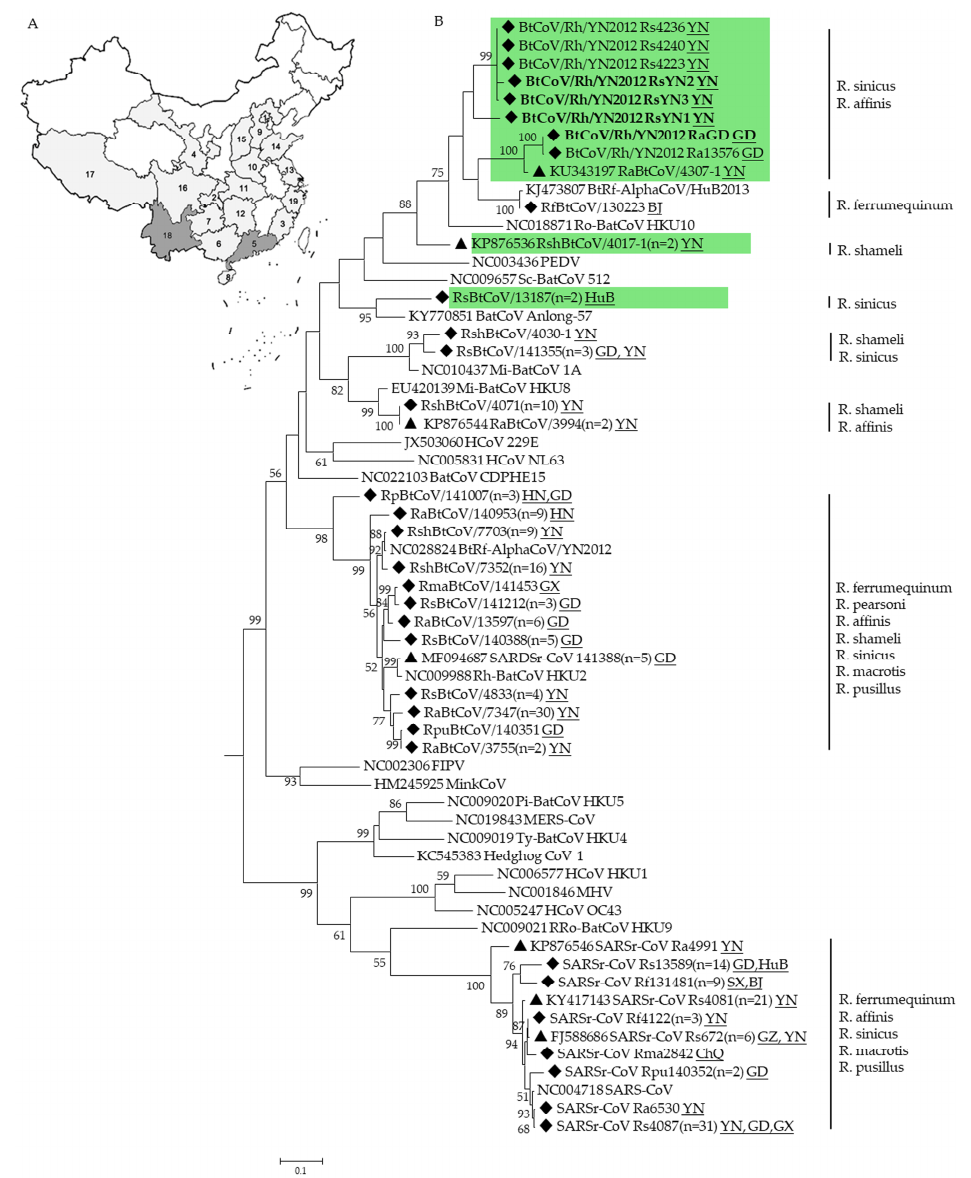
Figure 1. Sampling map ( A ) and phylogenetic analysis of CoVs detected in Rhinolophus bats ( B ). A total of 19 provinces (indicated in gray) in China were involved. 1. Beijing (BJ); 2. Chongqing (CA); 3. Fujian (FJ); 4. Gansu (GS); 5. Guangdong (GD); 6. Guangxi (GX); 7. Guizhou (GZ); 8. Hainan (HaN); 9. Hebei (HeB); 10. Henan (HeN); 11. Hubei (HuB); 12. Hunan (HuN); 13.Jiangsu (JS); 14.Shandong (SD); 15.Shanxi (SX); 16. Sichuan (SC). 17. Tibet (T); 18. Yunnan (YN); and 19. Zhejiang (ZJ). The partial sequences of RdRp gene (327-bp) of CoVs detected in Rhinolophus bats were aligned with those of published representative CoV strains. The tree was constructed by the maximum-likelihood method with bootstrap values determined with 1000 replicates. The scale bar indicates the estimated number of substitutions per 10 nucleotides. Filled triangles indicate the CoVs published previously by our lab (KU343197, KP876536, KP876544, MF094687, KP876546, KY417143, FJ588686) [15,18,40,41], filled diamonds indicate CoVs detected in this study. Putative novel alphaCoVs are labeled in green. BtCoV / Rh / YN2012 detected in Guangdong and Yunnan province in this study are in bold. FIPV, Feline infectious peritonitis virus; PEDV, porcine epidemic diarrhea virus; MHV, mouse hepatitis virus. Other abbreviations are defined as those in the text. Numbers in parentheses indicate numbers of sequences sharing > 97%